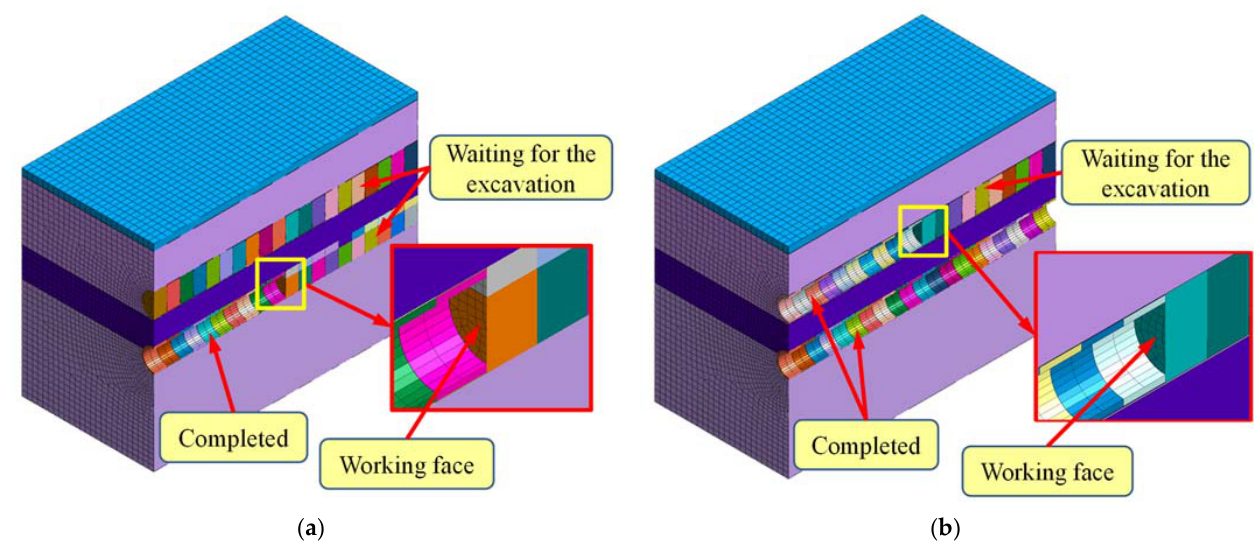
Figure 8. The simulation of construction process. ( a ) Lower pipe jacking; ( b ) upper pipe jacking.